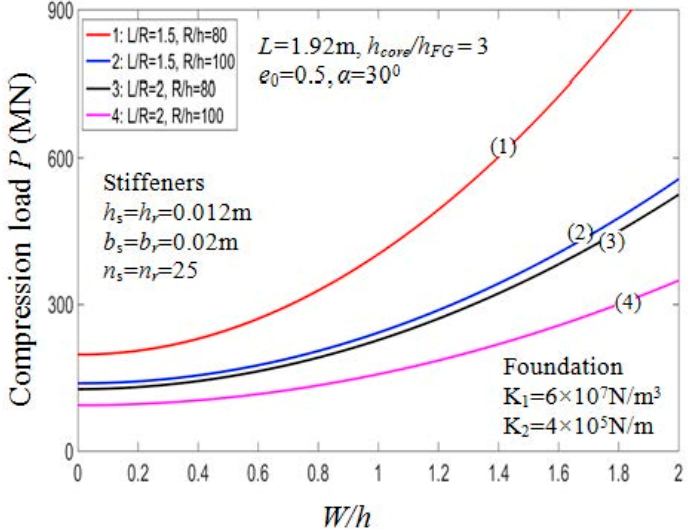
Figure 9. Effects of R / h and L / R on postbuckling load—deflection curves (Case 1, k 2 = k 3 = k = 1).